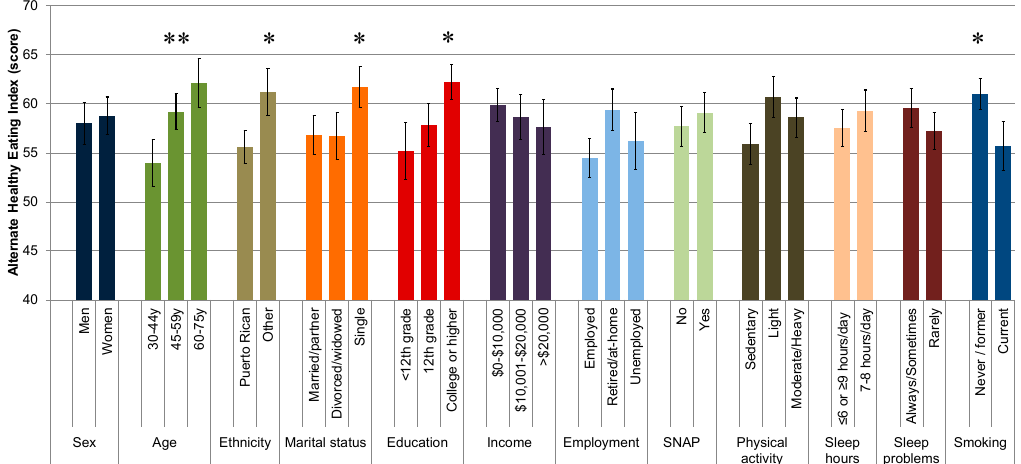
Figure 2. Mean (standard error) of the Alternate Healthy Eating Index by sociodemographic and lifestyle factors in adults living in Puerto Rico. Shown as mean (standard error) from a multivariable-adjusted general linear model including all variables shown and total energy intake. AHEI score is a range of 0–110 points with higher scores indicative of better diet quality. Significant factors shown as * p < 0.05; ** p < 0.01. n =